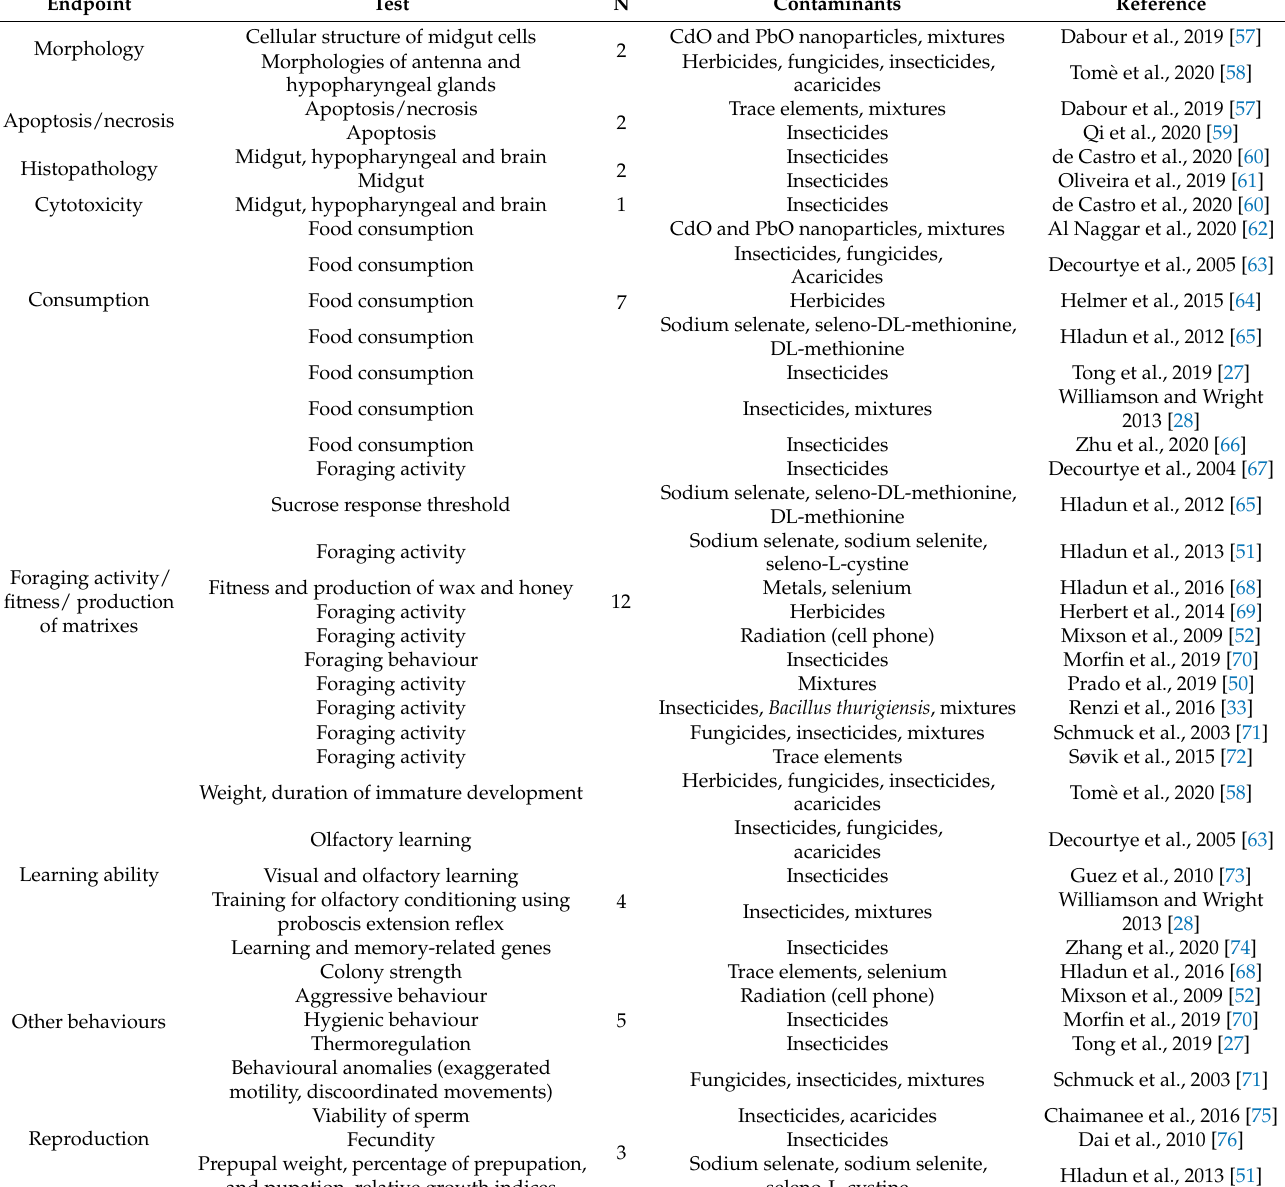
Table 1. Summary of laboratory studies divided by endpoint and